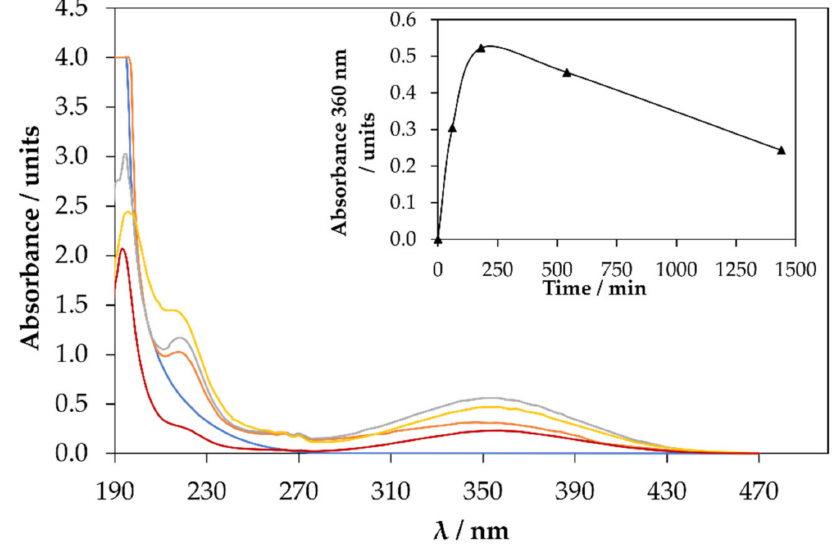
Figure 2. Changes in the UV-vis spectrum over 24 h during the liquid reaction of chlorate and Figure 1. UV-vis spectra ( a ) and deconvoluted UV-vis spectra lines ( b ) of samples containing H 2 SO 4 Figure 1. UV-vis spectra ( a ) and deconvoluted UV-vis spectra lines ( b ) of samples containing H 2 SO 4 Figure 1. UV-vis spectra ( a ) and deconvoluted UV-vis spectra lines ( b ) of samples containing H 2 SO 4 Figure 1. UV-vis spectra ( a ) and deconvoluted UV-vis spectra lines ( b ) of samples containing H 2 SO 4 Figure 1. UV-vis spectra ( a ) and deconvoluted UV-vis spectra lines ( b ) of samples containing H 2 SO 4 hydrogen peroxide in strongly acidic media. ( 5 M ( 25AC ), ClO 3 − 4.7 mM ( ▬ ), HClO 6.7 mM ( ▬ ), ClO − 5.4 mM ( ▬ ), chlorite 1.5 mM ( ▬ ). ) 0 h, ( 5 M ( 25AC ), ClO 3 − 4.7 mM ( ▬ ), HClO 6.7 mM ( ▬ ), ClO − 5.4 mM ( ▬ ), chlorite 1.5 mM ( ▬ ). ) 1 h, ( 5 M ( 25AC ), ClO 3 − 4.7 mM ( ▬ ), HClO 6.7 mM ( ▬ ), ClO − 5.4 mM ( ▬ ), chlorite 1.5 mM ( ▬ ). ) 3 h, ( 5 M ( 25AC ), ClO 3 − 4.7 mM ( ▬ ), HClO 6.7 mM ( ▬ ), ClO − 5.4 mM ( ▬ ), chlorite 1.5 mM ( ▬ ). ) 9 h and ( 5 M ( 25AC ), ClO 3 − 4.7 mM ( ▬ ), HClO 6.7 mM ( ▬ ), ClO − 5.4 mM ( ▬ ), chlorite 1.5 mM ( ▬ ). ) 24 h. The inset panel shows the absorbance of chlorine dioxide (360 nm) produced in the system during the